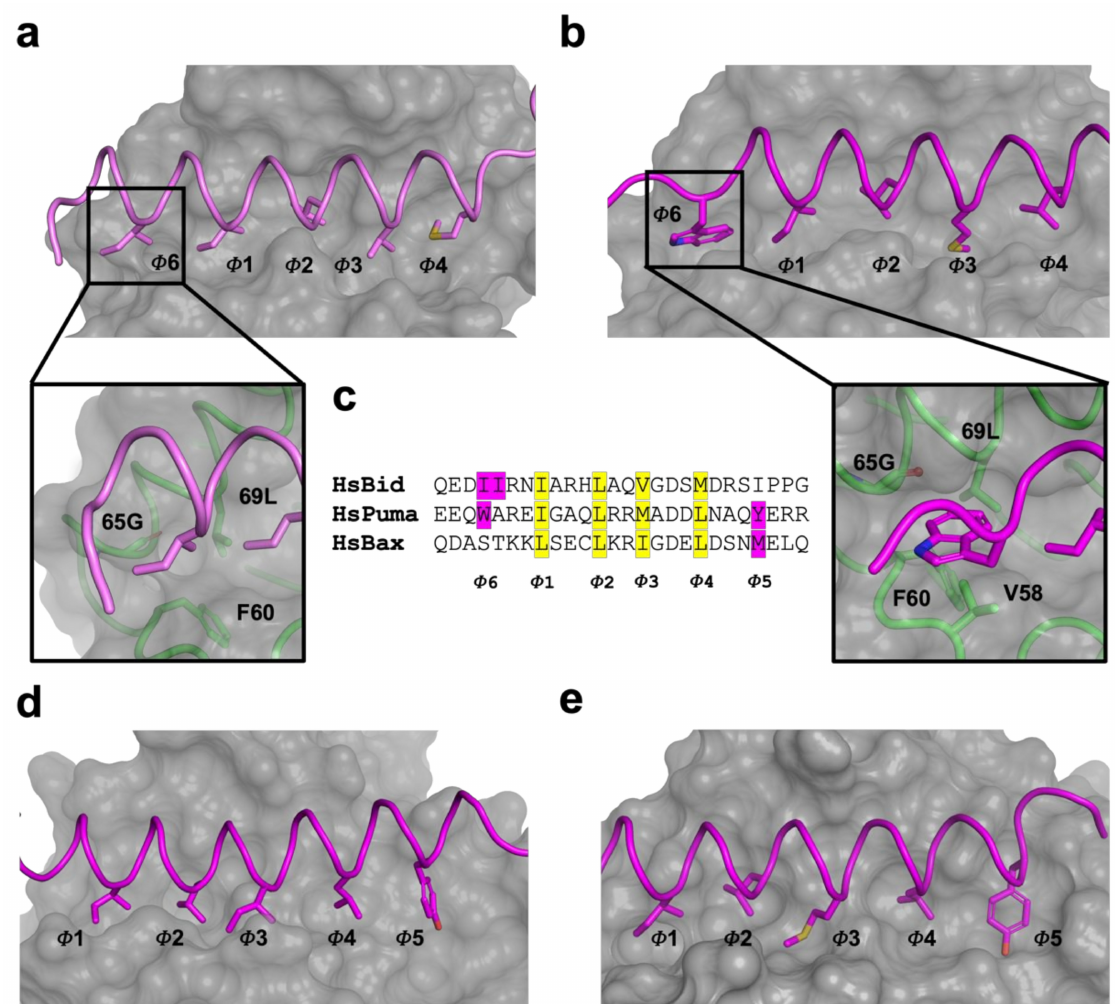
Figure 4. Engagement of an additional hydrophobic pocket (fifth pocket) in viral Bcl-2 proteins with BH3motif peptides. ( a ) Hydrophobic binding groove of KsBcl-2:Bid BH3 complex. The hydrophobic pockets of the binding groove are labelled as Φ 1– Φ 6. The surface of the KsBcl-2 is shown in grey with side chains of the key hydrophobic residues located in the pocket Φ 1– Φ 6 shown as sticks. Bid BH3 backbone is shown as cartoon tube (pink). An enlarged view of the fifth hydrophobic pocket of KsBcl-2 is shown in the bottom panel with a cartoon tube of the KsBcl-2 backbone (green), with residues involved in forming the fifth hydrophobic pocket labelled. ( b ) Hydrophobic binding groove of KsBcl-2:Puma BH3 complex. Puma BH3 backbone is shown as cartoon tube (magenta). The surface, hydrophobic pockets of the binding groove and key residues are shown as in ( a ). ( c ) sequence of the key BH3 motif peptides (Bid, Puma and Bax) involved to engage fifth hydrophobic pocket with viral Bcl-2 proteins are shown. Conserved four hydrophobic residues engage with hydrophobic pockets are highlighted in yellow and labelled Φ 1– Φ 4. The additional hydrophobic residues engaging with the fifth hydrophobic pocket are highlighted in magenta and labelled as Φ 5 (C-terminal pocket) and Φ 6 (N-terminal pocket). ( d ) Hydrophobic binding groove of Mcl-1:Puma BH3 complex. Puma BH3 (magenta) backbone is shown as cartoon tube. ( e ) Hydrophobic binding groove of ORFV125:Puma BH3 complex. Puma BH3 (magenta) backbone is shown as cartoon tube. The surface, hydrophobic pockets of the binding groove and key residues are shown as in ( a